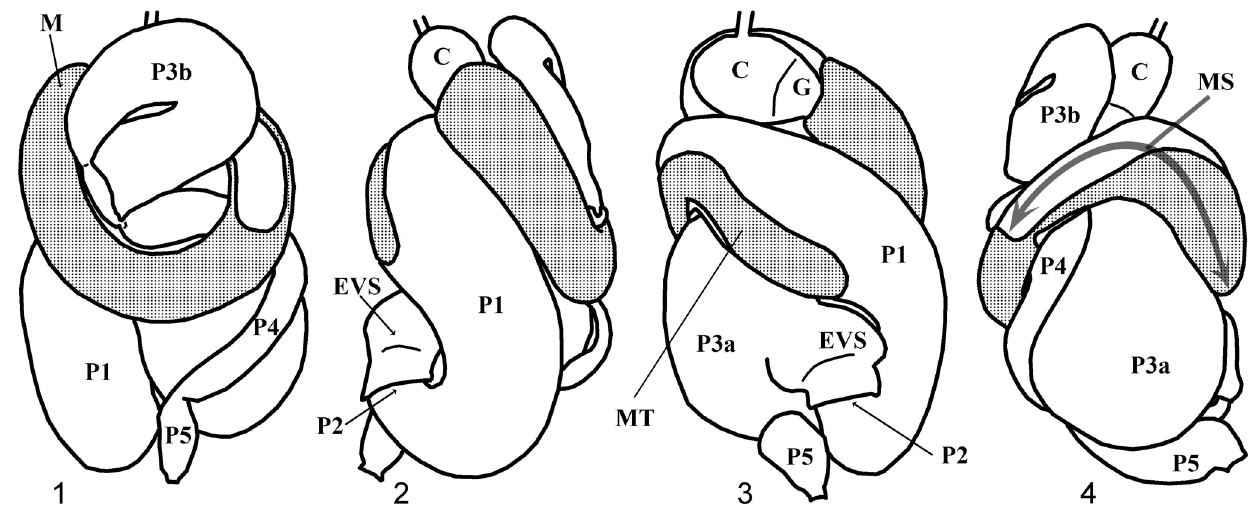
Figs 1–4. Worker gut of Cornitermes cumulans in 1- dorsal; 2- left; 3- ventral and 4- right views [foregut with crop (C), gizzard (G); midgut: mesenteron (M); mixed segment (MS), mesenteric tongue (MT) and hindgut with ileum (P1), enteric valve (P2), enteric-valve seating (EVS), paunch (P3a and P3b), colon (P4) and rectum (P5)], (figures not to